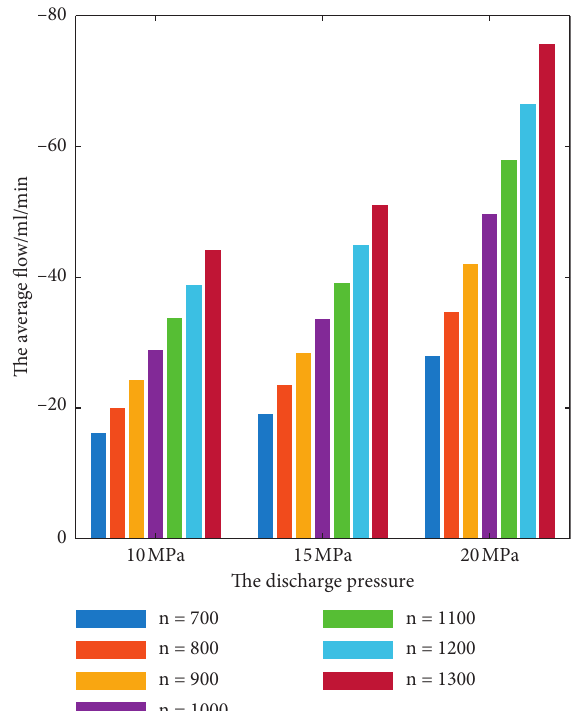
Figure 14: The average leakage flow of PRBC per piston at different